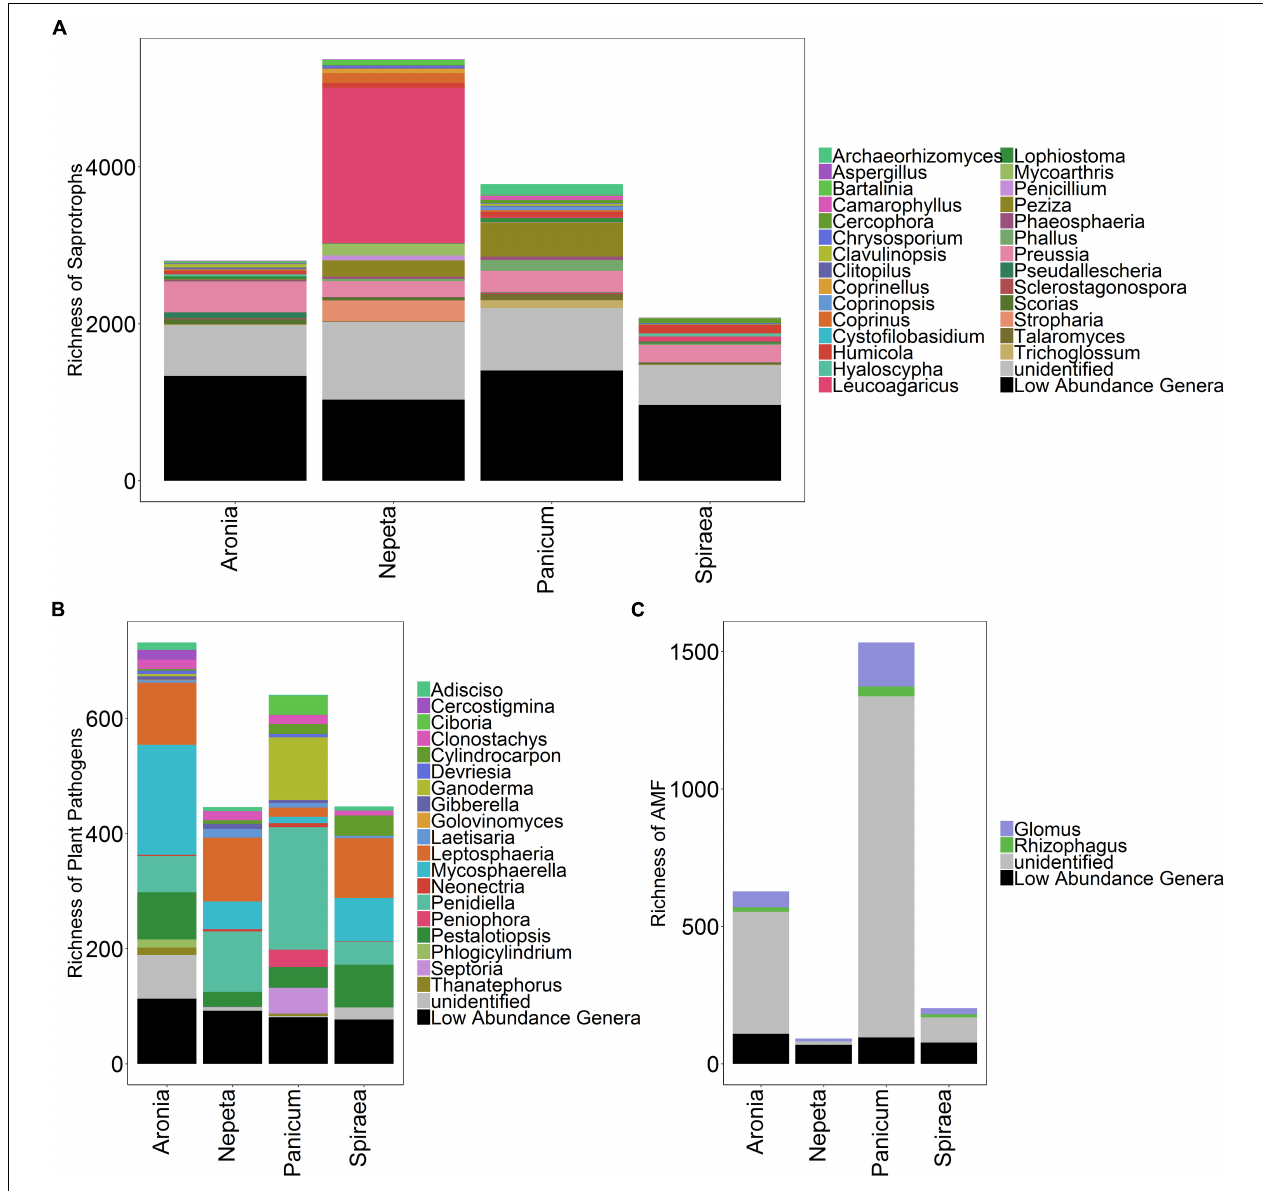
FIGURE 4 | Richness of saprotrophs (A) , plant pathogens (B) , and arbuscular mycorrhizal fungi (C) isolated from soils collected near the five target plant